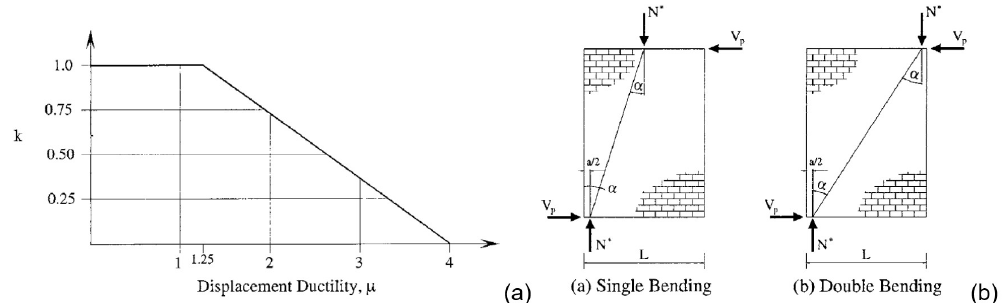
Figure 9. (a) Relationship between ductility and reduction factor; (b) Contribution of axial load to masonry shear strength